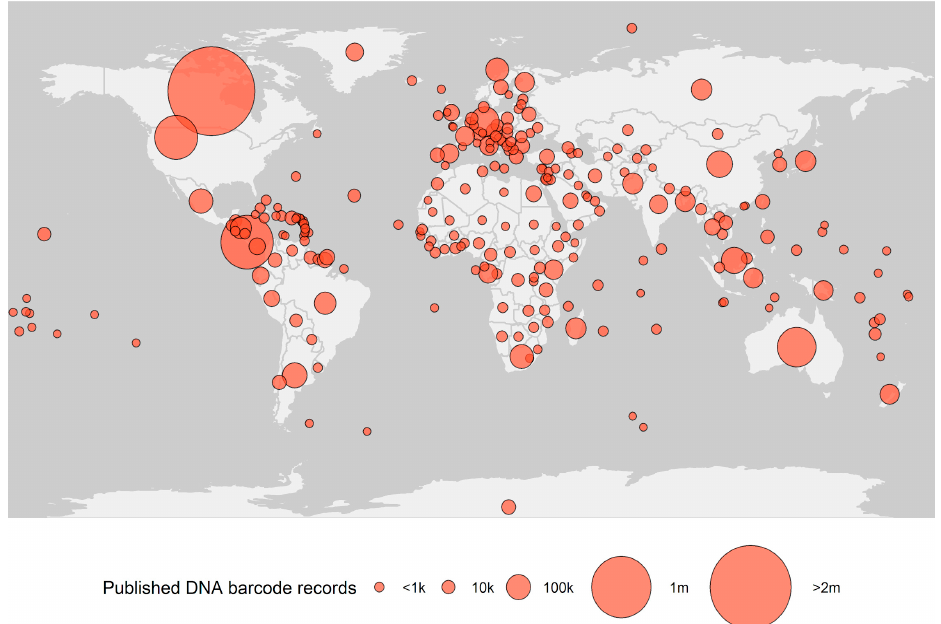
Figure 1. Number of public DNA barcodes available in Barcode of Life Data Systems (BOLD) by country (obtained 1 January, 2021).